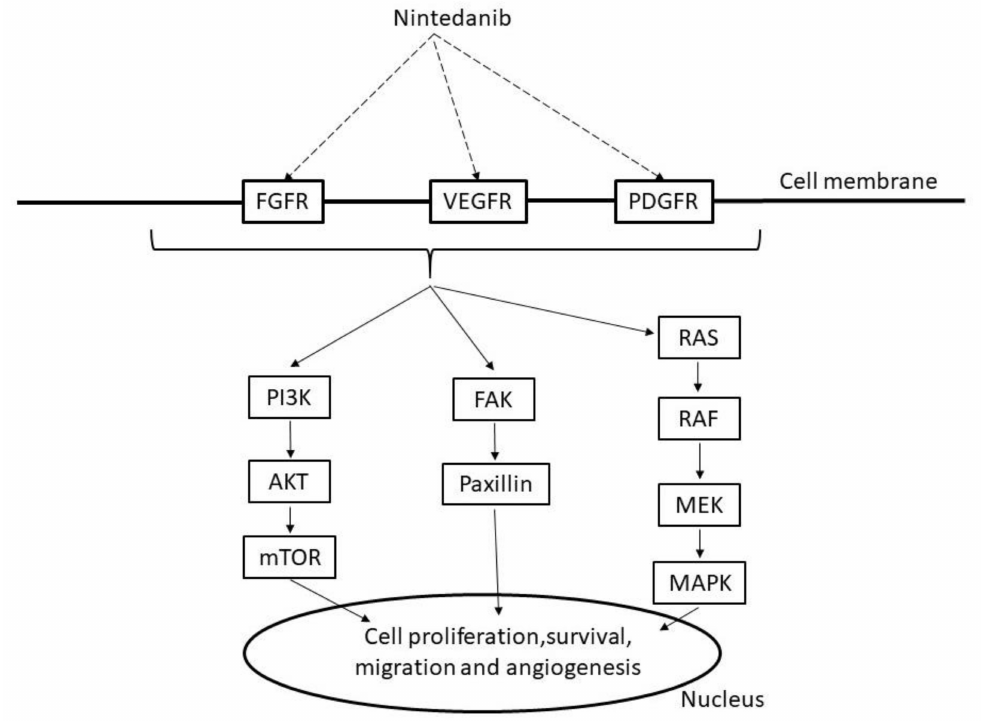
Figure 3. Mechanism of nintedanib. FGFR: fibroblast growth factor receptors, VEGFR: vascular endothelial growth factor receptor, PDGFR: platelet-derived growth factor receptors, PI3K: phosphoinositide 3 kinase, AKT: v-act murine thymoma viral oncogene homolog, mTOR: mammalian target of rapamycin, FAK: focal adhesion kinase, RAS: rat sarcoma protein, RAF: v-raf murine viral oncogene homolog, MAPK: mitogen activated protein kinase, MEK:,MAPK / extracellular signal regulated kinase(ERK)